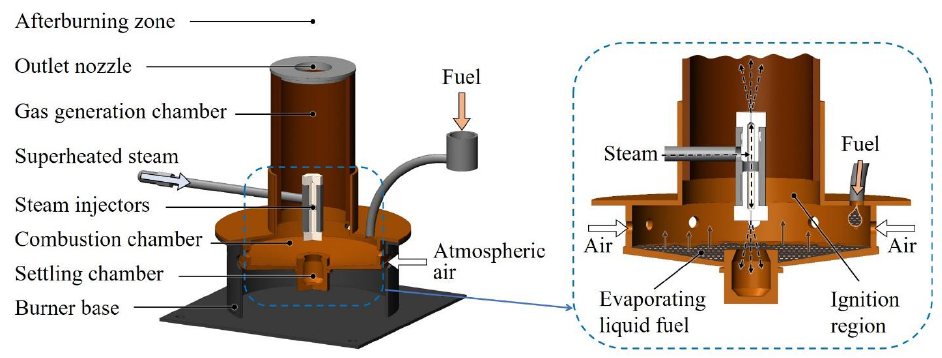
Figure 2. Scheme of the processes in the evaporation burner.